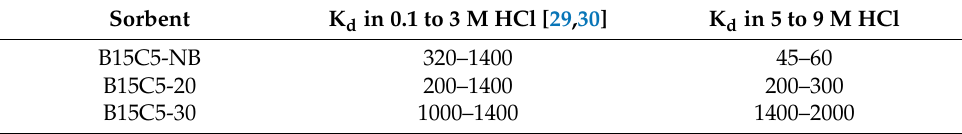
Table 2. K d of gold(III) (mL/g) on the studied sorbents in HCl.